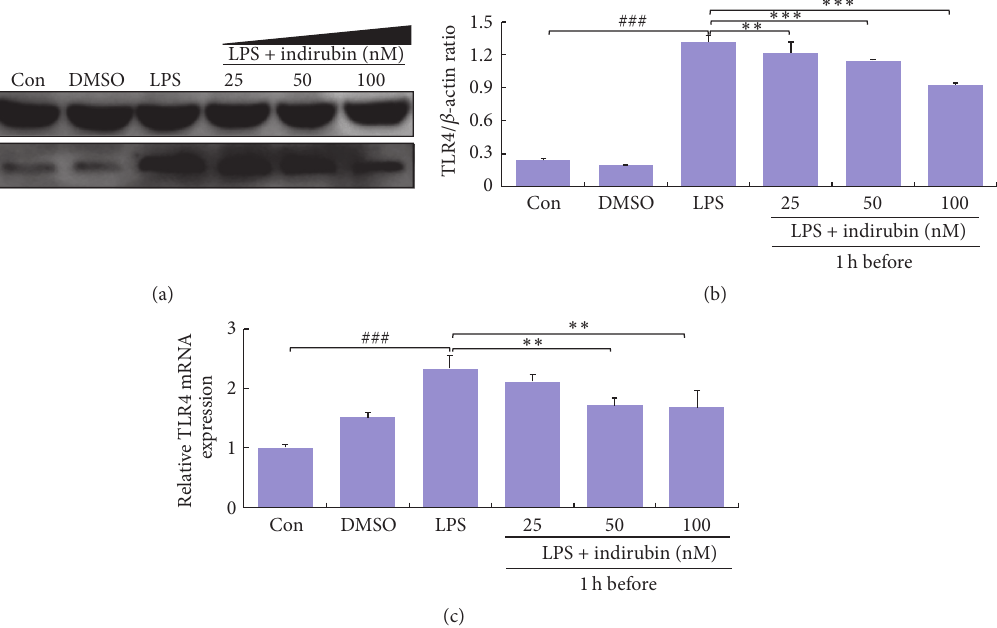
Figure 5: Effects of indirubin on TLR4 expression in LPS-induced MMECs. (a) Cells proteins were analyzed by western blotting. (b) Densitometric analysis of the effects of different concentrations of indirubin on TLR4 expression. (c) mRNA were analyzed by qRT-PCR. Data are presented as means ± SEM ( 𝑛 = 3 ). ### 𝑝 < 0.001 versus control group; ∗∗ 𝑝 < 0.01 and ∗∗∗ 𝑝 < 0.001 versus LPS group.